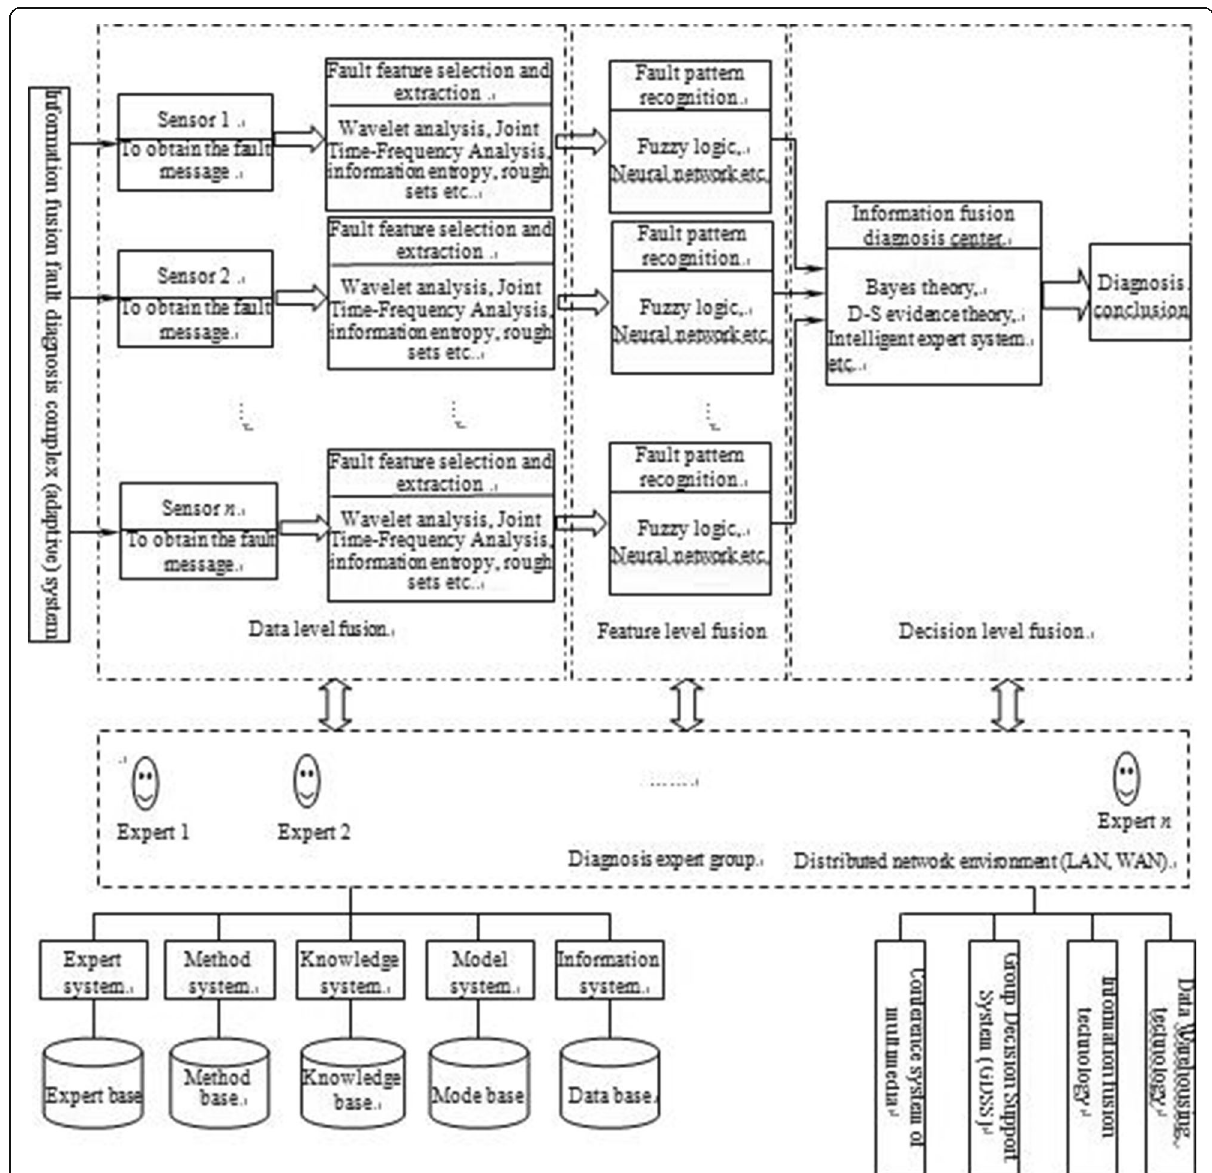
Fig. 4 The structure framework of HWME fault diagnosis system based on information